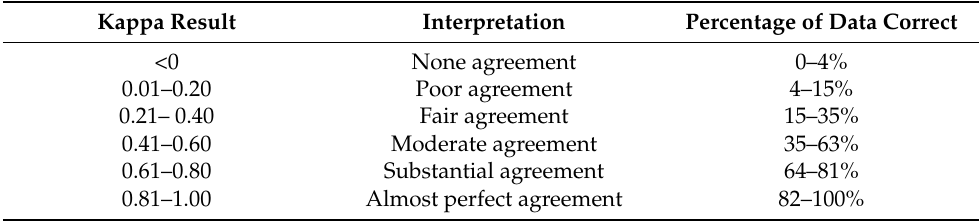
Table 2. Cohen’s Kappa coefficient interpretation for classifiers accuracy (adapted from